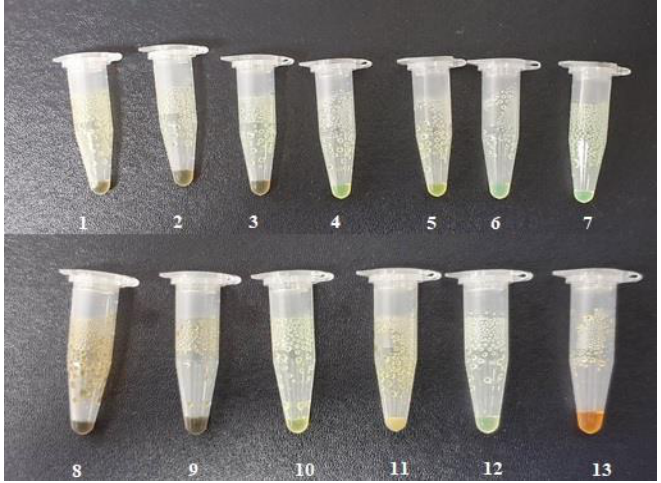
Figure 1. Appearances of the formed ILs: (1) DPZ-adipic acid; (2) DPZ-azelaic acid; (3) DPZ-glutaric acid; (4) DPZ-itaconic acid; (5) DPZ-maleic acid; (6) DPZ-malic acid; (7) DPZ-phthalic acid; (8) DPZ- pimelic acid; (9) DPZ-sebacic acid; (10) DPZ-succinic acid; (11) DPZ-suberic acid; (12) DPZ-tartaric acid and (13) DPZ- α ketoglutaric